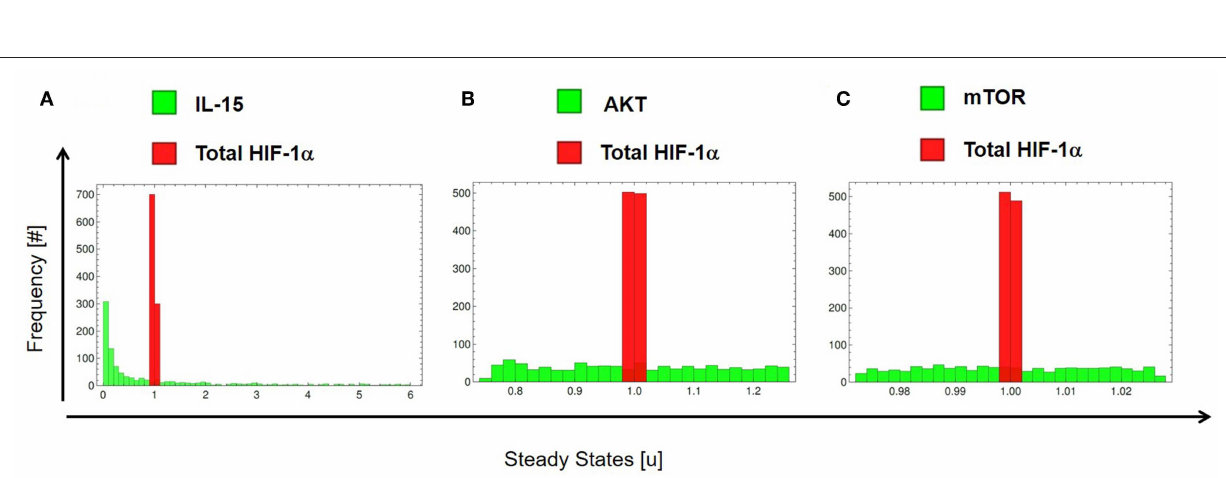
Frontiers in Immunology | www.frontiersin.org